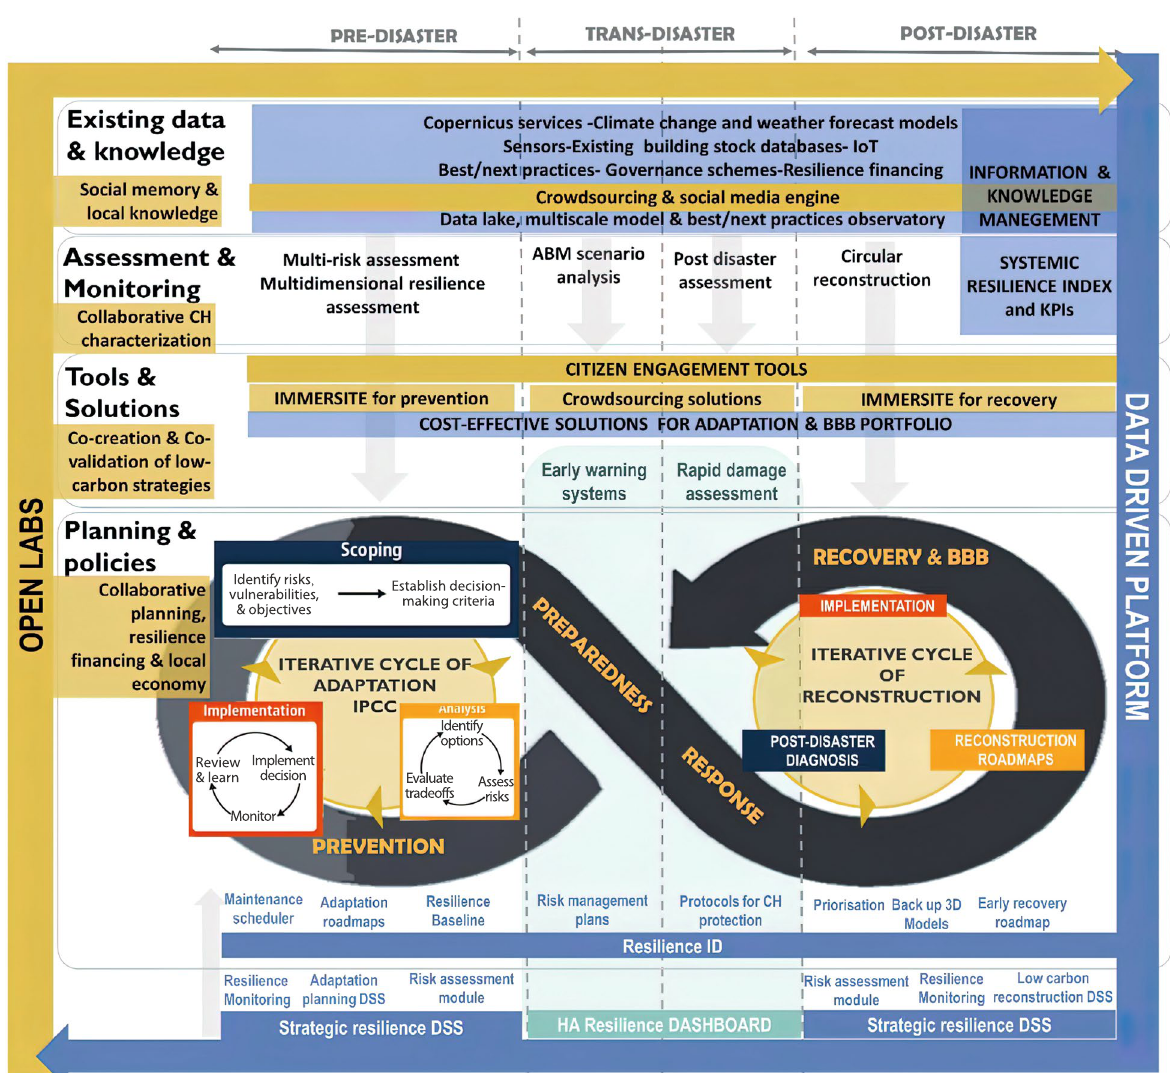
Fig. 1 Resilience concept of the SHELTER project. (Source: SHELTER